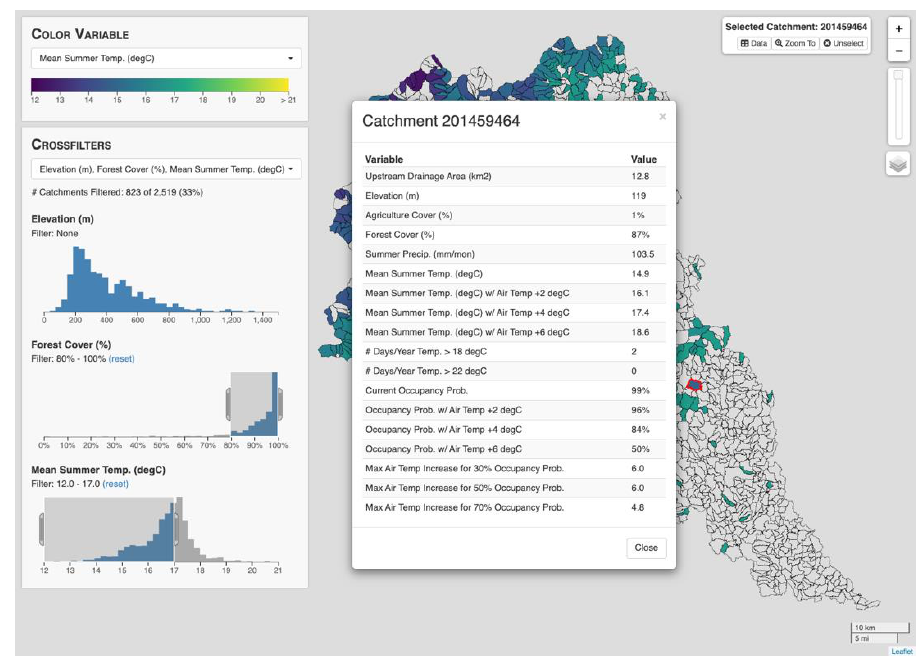
Figure 5. Screenshot showing a summary table of all dataset variables for a selected catchment.